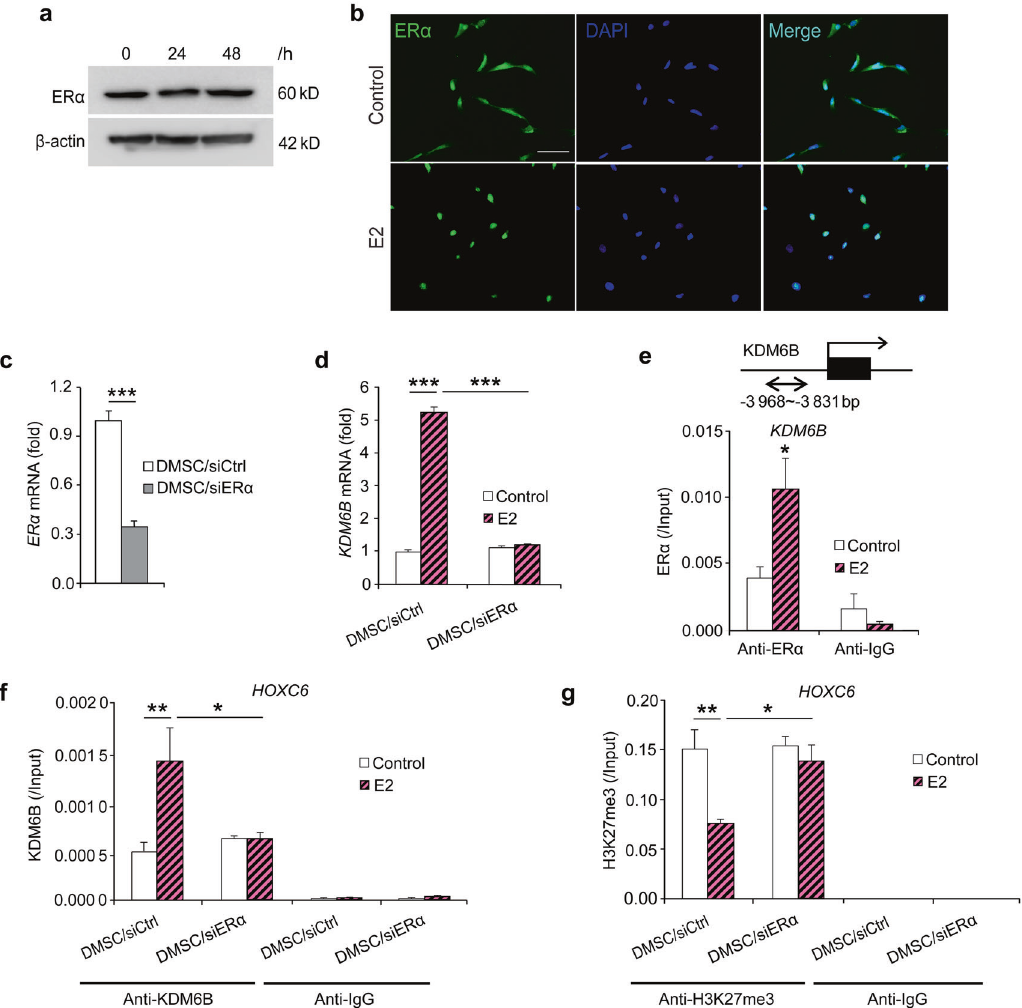
Fig. 5 E2-induced KDM6B expression through ER α in DMSCs. a ER α protein expression in DMSCs upon E2 treatment at 24 and 48 h by western blots. b ER α expression location in DMSCs upon E2 treatment at 4 h by immuno fl uorescence staining. c Depletion of ER α in DMSCs via siRNA by qRT-PCR. d qRT-PCR of KDM6B expression in the control and ER α -depleted DMSCs upon E2 treatment. e Occupancy of ER α at the KDM6B promoter, as determined by ChIP, upon E2 treatment. f Occupancy of KDM6B at the HOXC6 promoter in the control and ER α -depleted DMSCs, as determined by ChIP, upon E2 treatment. g Occupancy of H3K27me3 at the HOXC6 promoter in the control and ER α -depleted DMSCs, as determined by ChIP, upon E2 treatment. Data are presented as the mean ± SEM ( n = 3). For c and d , data are shown as fold expression of target genes after normalization to DMSC/ siCtrl . For c , two groups were compared by two-tailed t -tests. For d – g , all the groups were compared by two-way ANOVA with a Bonferroni post hoc test. Asterisks were assigned to P values with statistical signi fi cance (* P < 0.05; ** P < 0.01; *** P <